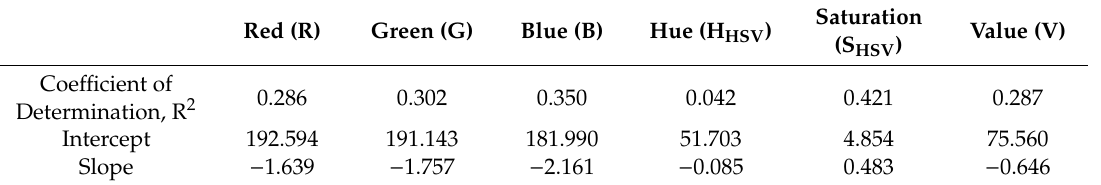
Table 1. Linear regression parameter between R, G, B, H HSV , S HSV , V and PM 10 concentrations for all samples collected in Badajoz and Monfragüe during 2015.